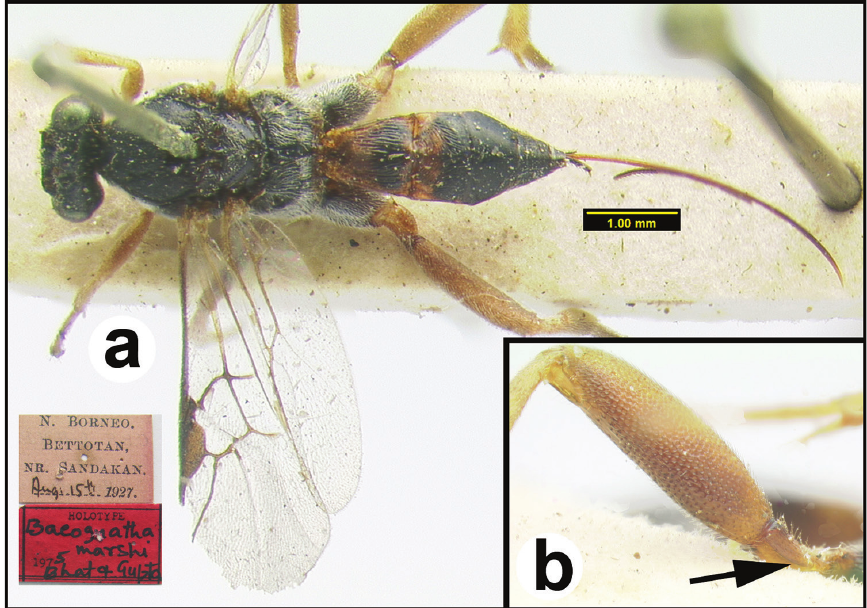
Figure 15. Trochantagathis marshi holotype female: a dorsal habitus b hind femur showing one of the two ridges on the trochantellus.